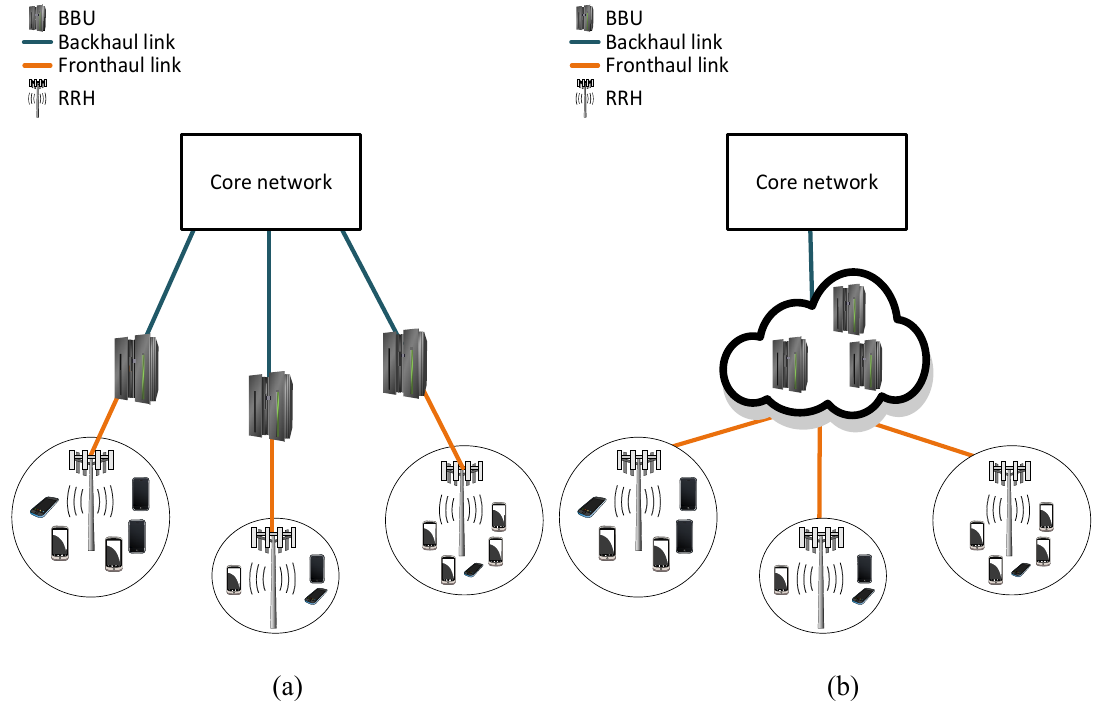
Figure 2. ( a ) Architecture of RAN with distributed RRH, ( b ) Architecture of cloud RAN.